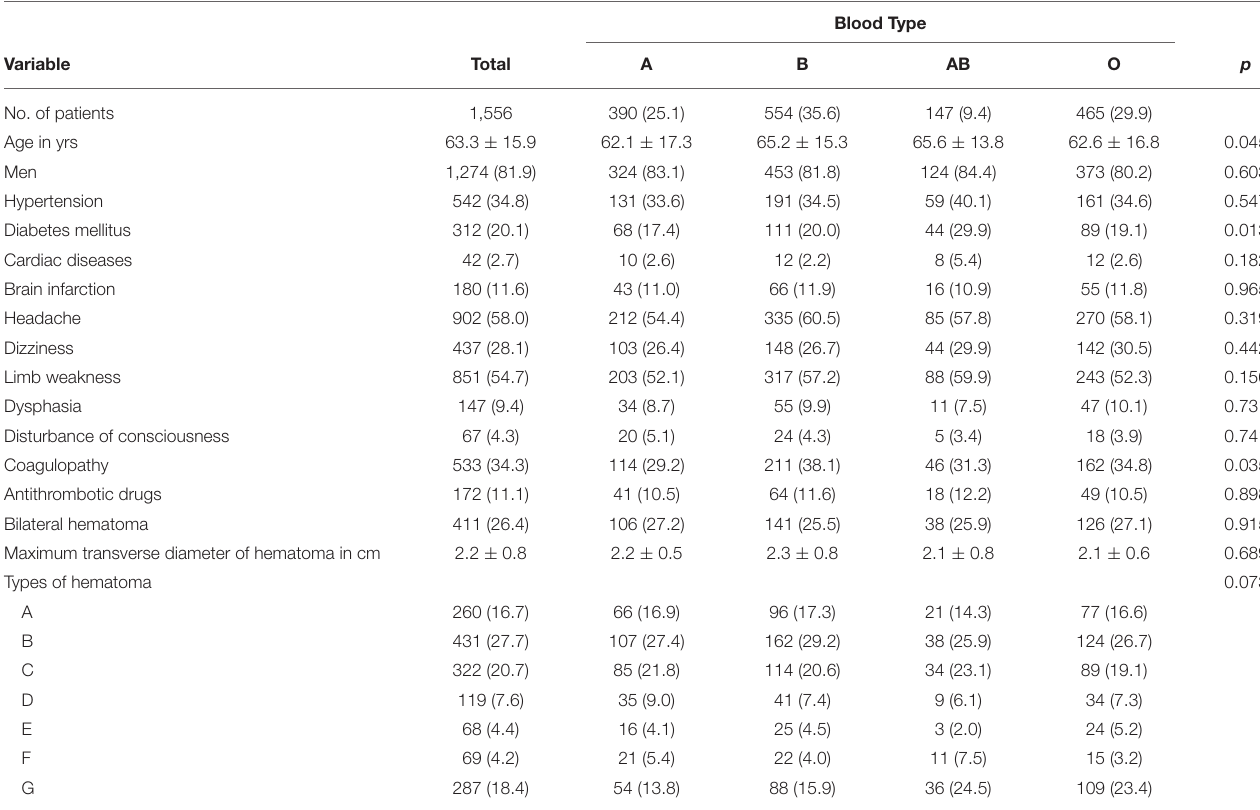
TABLE 1 | Preoperative clinical features of 1,556 patients with CSDH.